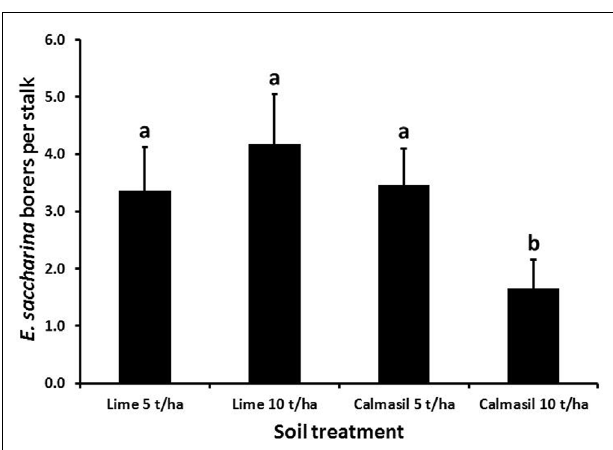
FIGURE 3 | Mean ( ± SE) percent stalk length bored by E. saccharina in sugarcane cultivars (N27 and N33) amended with Calmasil and lime at two different rates inTrial 1. Bars with the same letter/s above them do not differ significantly (Holm–Sidak test, p < 0.05).